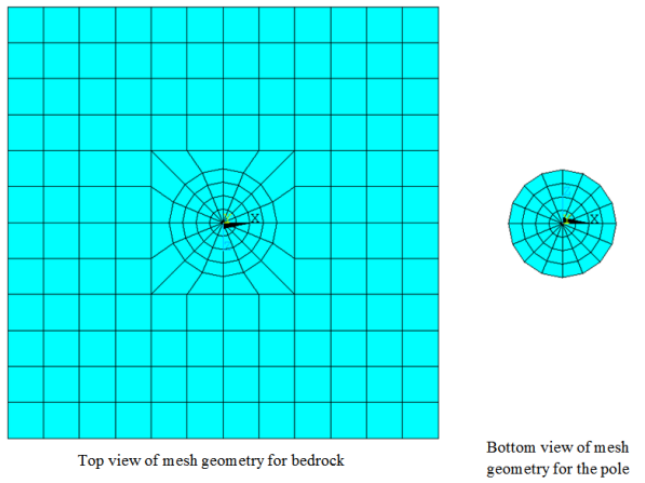
Figure 4. Mesh geometry of FE model for the contact surface.